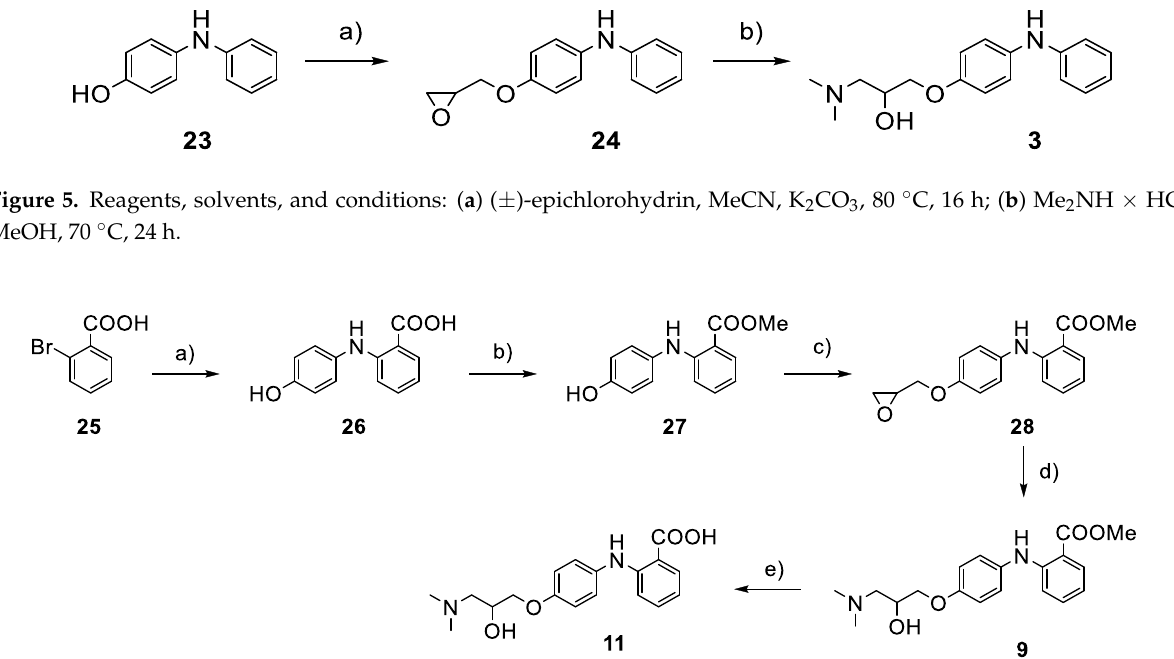
Figure 6. Reagents, solvents, and conditions: ( a ) 4-aminophenol, K 2 CO 3 , CuO, Cu, 2-ethoxyethanol, 130 °C, 16 h; ( b ) thionyl chloride, anhydrous MeOH, 70 °C, overnight; ( c ) (±)-epichlorohydrin, MeCN, K 2 CO 3 , 80 °C, 16 h; ( d ) NaOH, MeOH, water, r.t., 12 h.